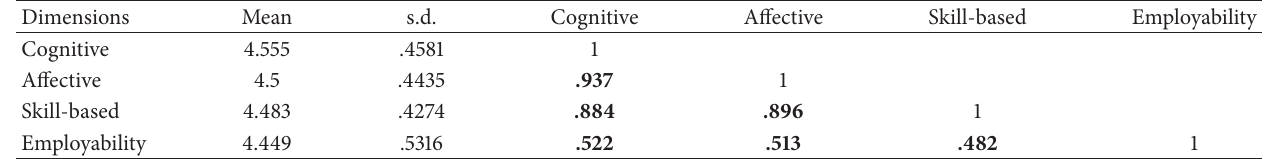
Table 7: Correlation analysis—industry